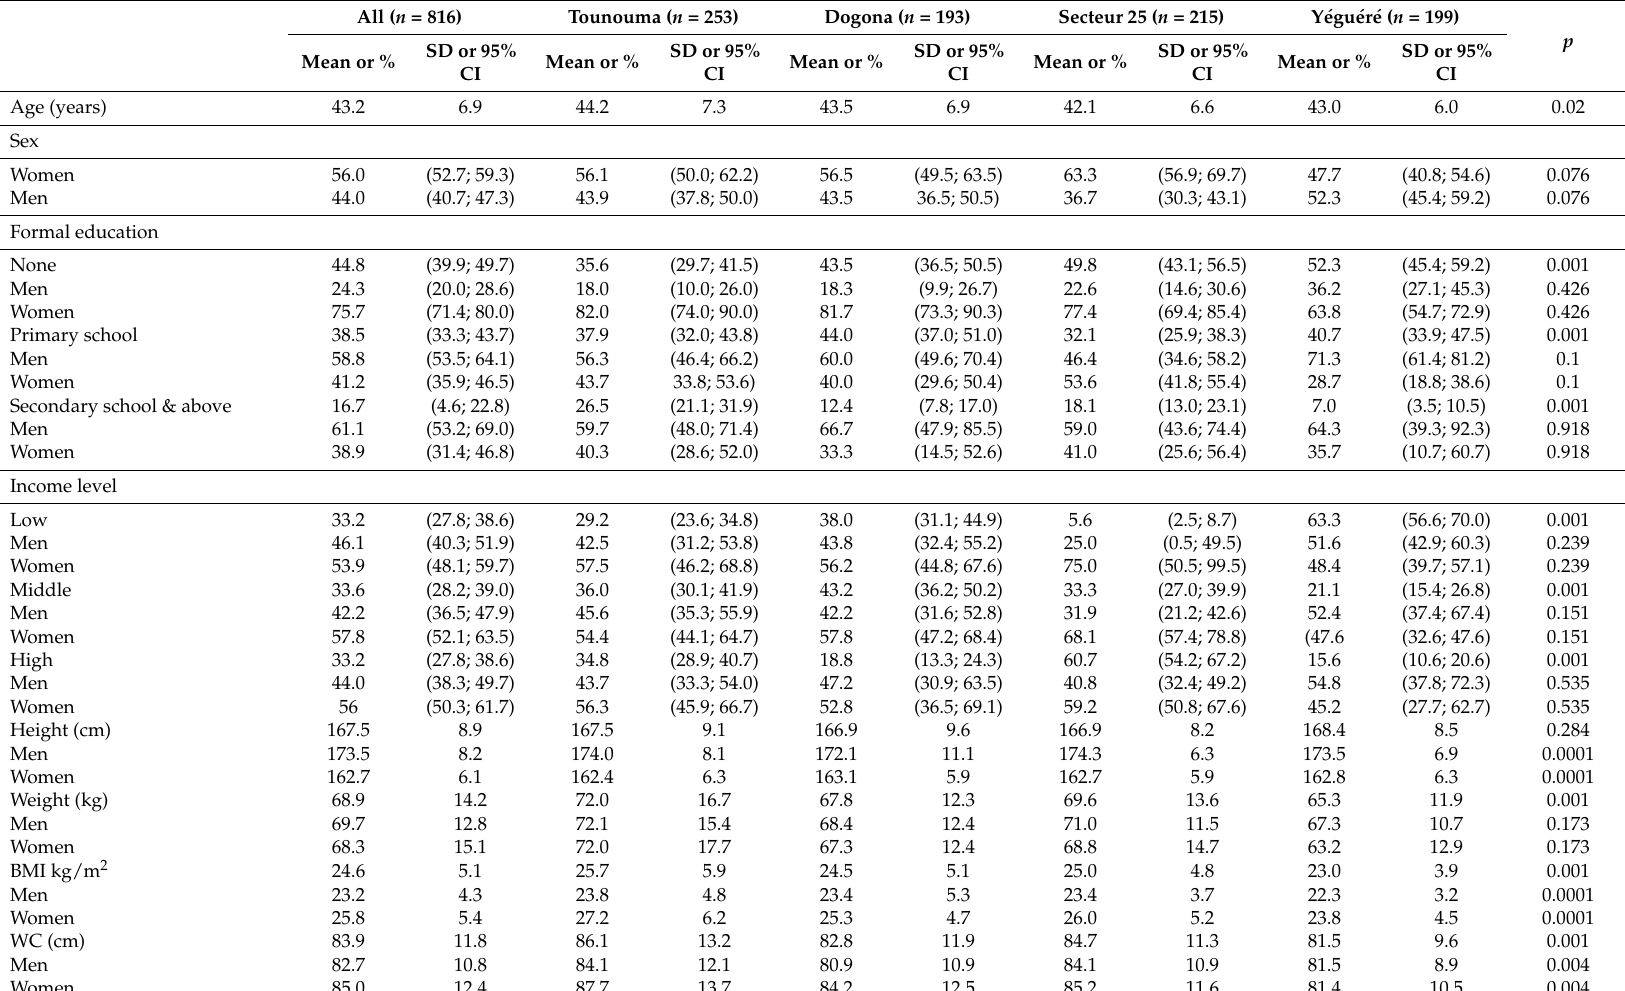
Table 2. Socio-demographic characteristics, nutritional status and cardiometabolic risk markers by sector of